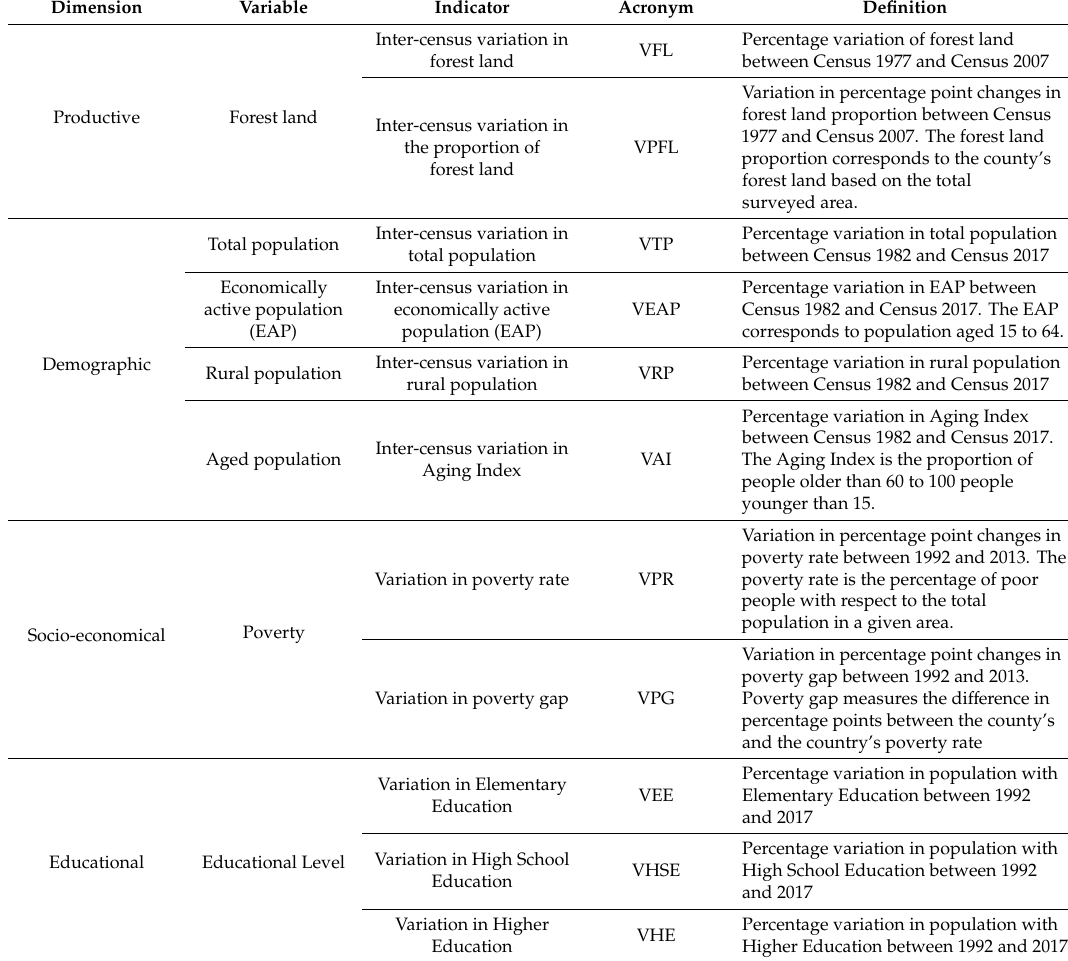
Table 1. Variables and indicators in land use